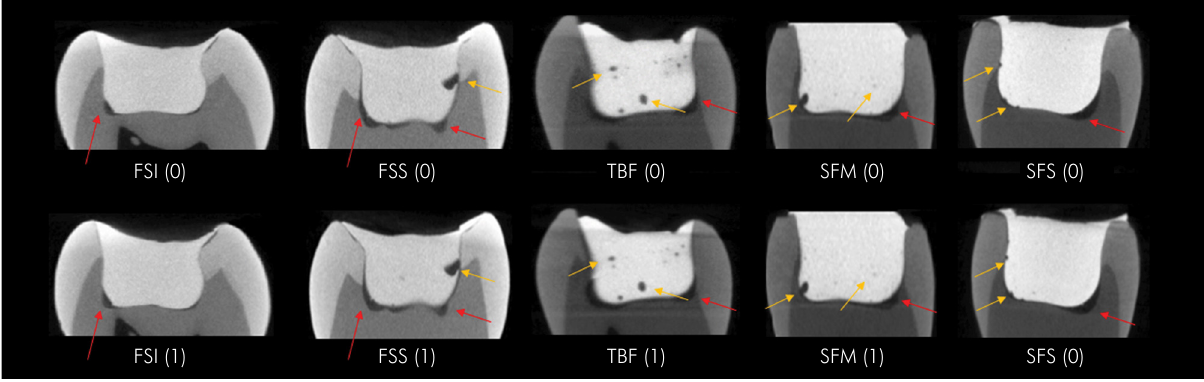
Figure 3. Presence of gaps and voids in the resins before (0) and after (1) light curing indicated by arrows in the µCT (red=gap; yellow=void). FSI: Filtek Supreme XTE - incremental insertion; FSS: Filtek Supreme XTE - single insertion; TBF: Tetric Bulk Fill; SFM: SonicFill - manual filling; SFS: SonicFill - sonic filling.